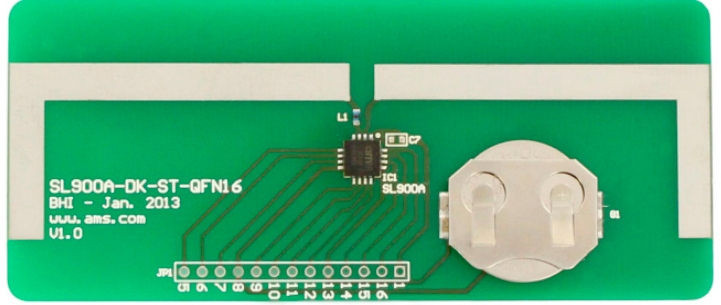
Figure 2. SL900A evaluation board.